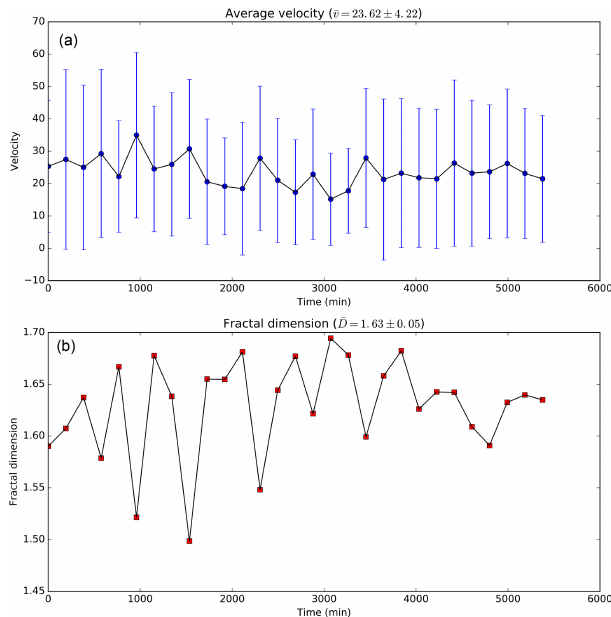
Figure 7. Temporal evolution of the average velocity (a) and fractal dimension (b) for the flow around the